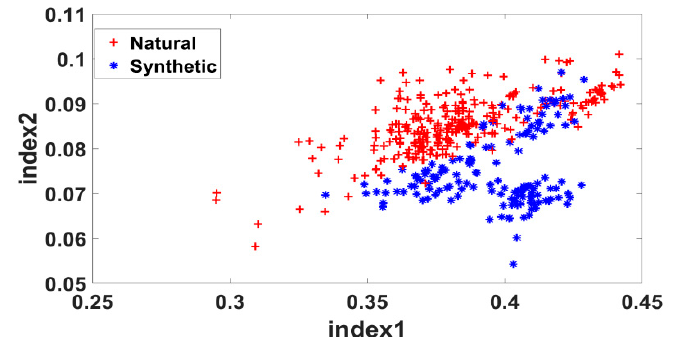
Figure 8. Reflectance spectra transformed to ratio of absorption and scattering coefficients (K/S) and the locations of selected bands (1140 nm, 1500 nm, 1660 nm) indicated by vertical lines.